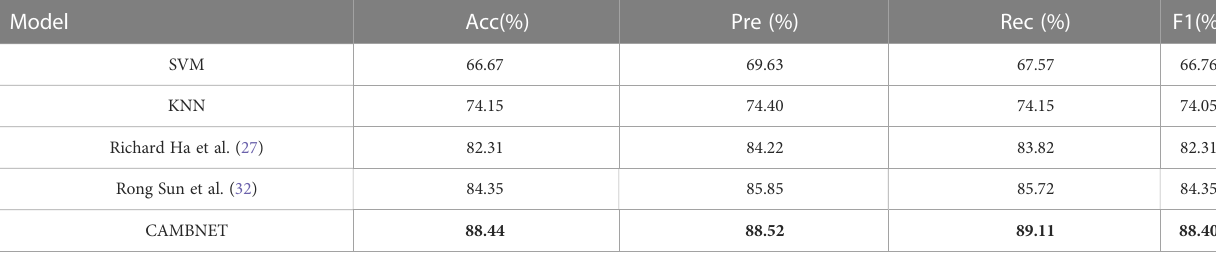
TABLE 4 Comparison of CAMBNET with other methods.